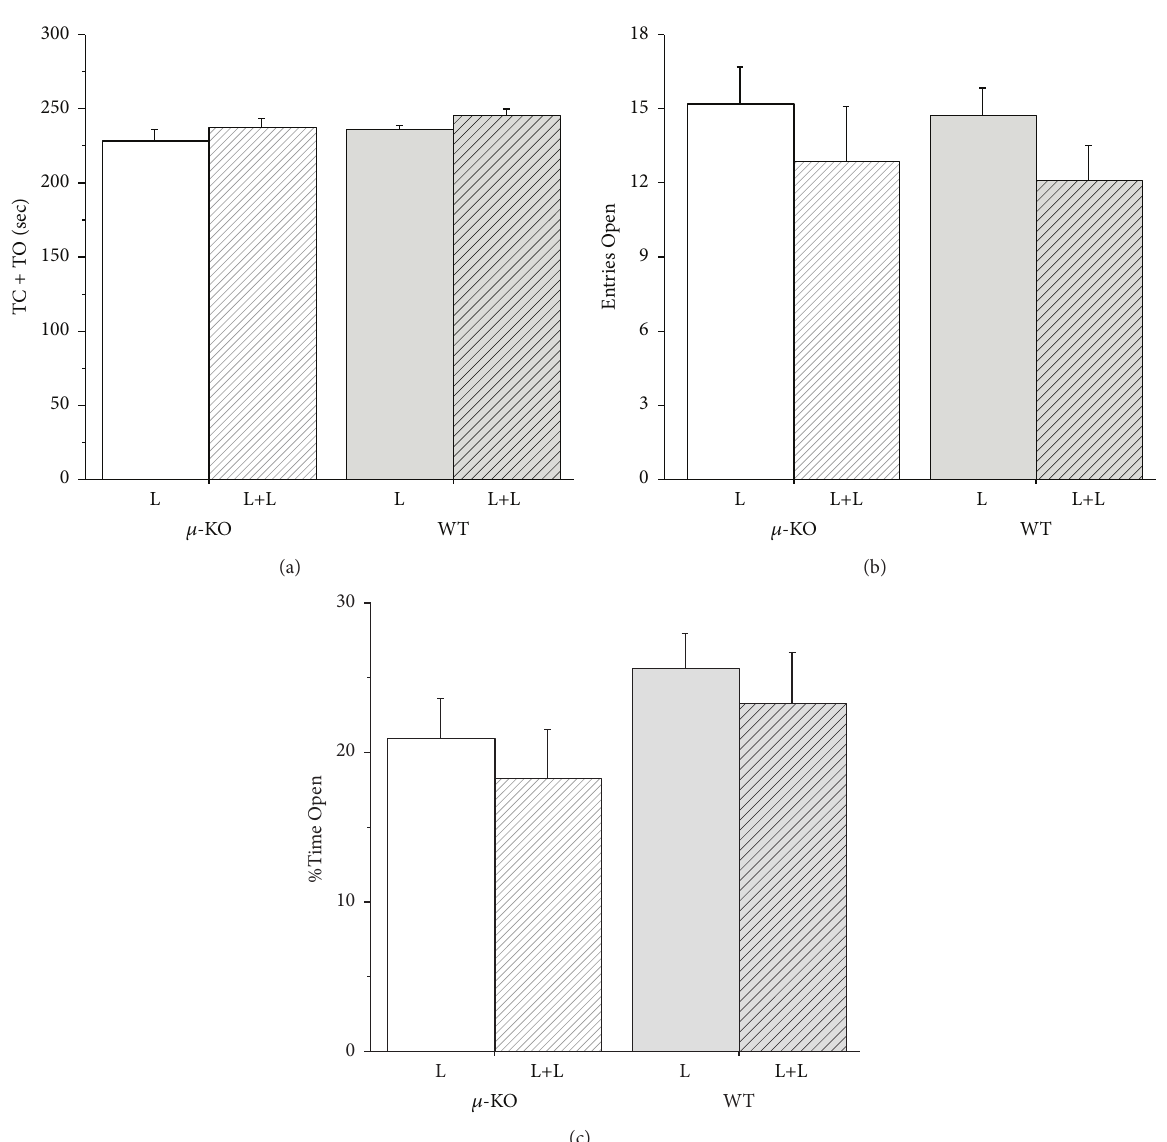
Figure 3: Adult mice emotionality measure in the plus maze apparatus: (a) Time Open + Time Closed, (b) number of entries in the open arms, and (c) percentage of time spent in the open arms. Data are presented as mean (+SEM). 𝑁 : 11–20 per group. 𝜇 -KO-L: Oprm1 −/− pups reared by their mother [9 males + 9 females]; 𝜇 -KO-L+L: Oprm1 −/− pups reared by their mother plus a second lactating female [6 males + 5 females]; WT-L: Oprm1 +/+ pups reared by their mother [8 males + 12 females]; WT-L+L: Oprm1 +/+ pups reared by their mother plus a second lactating female [11 males + 6